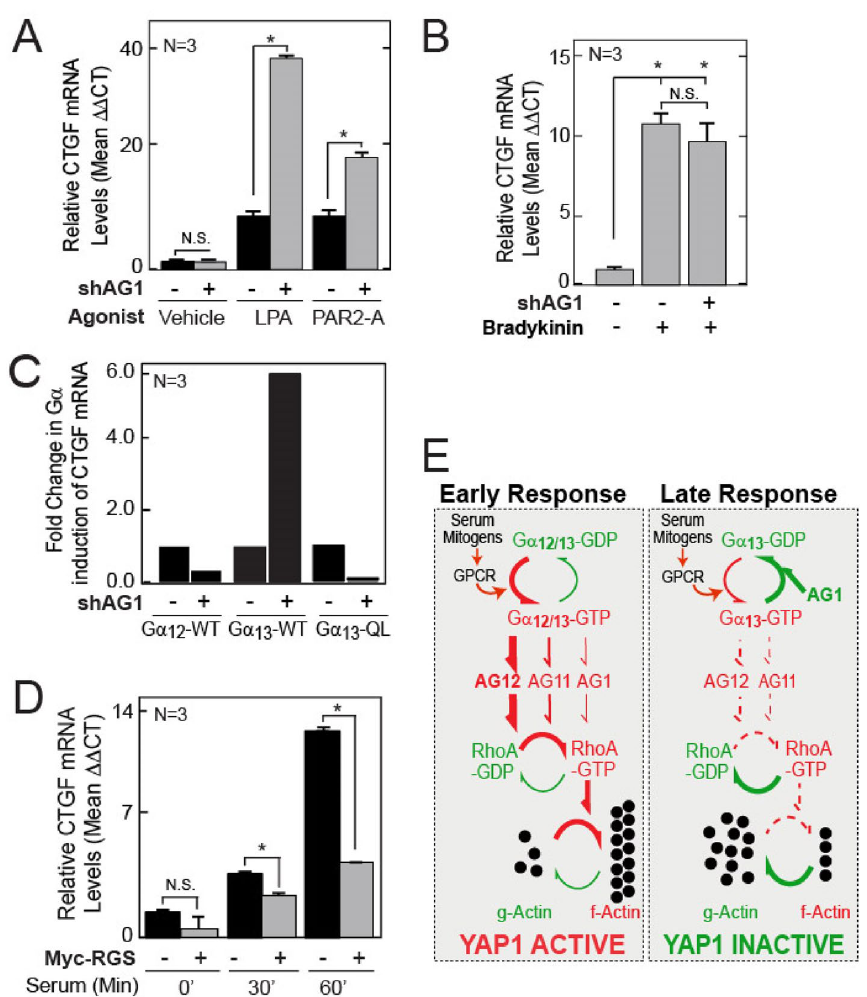
Figure 5. ArhGEF1 selectively inhibits Gα 13 to reduce the activation of Yap1 dependent transcription by serum. ( A ) Serum starved MCF7 cells transduced with control or shRNA against ArhGEF1 were treated for 30 min with vehicle, LPA (1 µM), or the PAR2-A peptide (5 µM). Fold-change in CTGF transcript levels was then determined using qRT-PCR. ( B ) MCF7 cells stably transduced with shControl or shArhGEF1 (shAG1) were treated for 30 min with vehicle or Bradykinin (10 nM). Fold-change in CTGF transcript levels were then measured by qRT-PCR ( C ) Fold induction of CTGF transcript in MCF7 cells infected with lentivirus encoding either shControl (−) or shArhGEF1 (shAG1) in combination with lentivirus that expresses either Flag-Control, Gα 12 -WT, Gα 13 -WT or the GTPase deficient Gα 13 -QL mutant. ( D ) Fold-change in CTGF transcript levels as measured by qRT-PCR from MCF7 cells expressing control or myc-tagged ArhGEF1-RGS. Before lysis, cells were serum starved for 24 h and then treated with media alone or media containing 10% FCS for 60 min. ( E ) Model for the combined activities of the RGS-RhoGEFs in serum signaling to